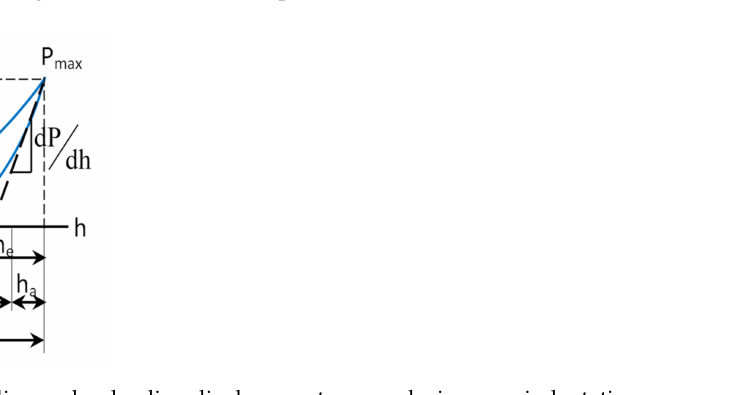
Figure 6. Height image obtained after performing nanoindentation experiments with three different force setpoints using the AFM indentation tip.